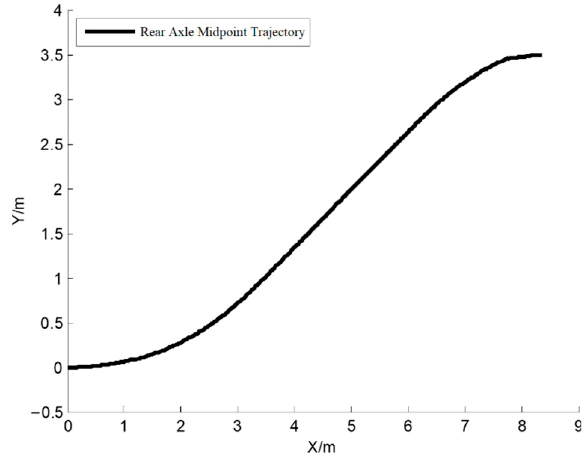
Figure 22. Rear Axle Midpoint Trajectory.